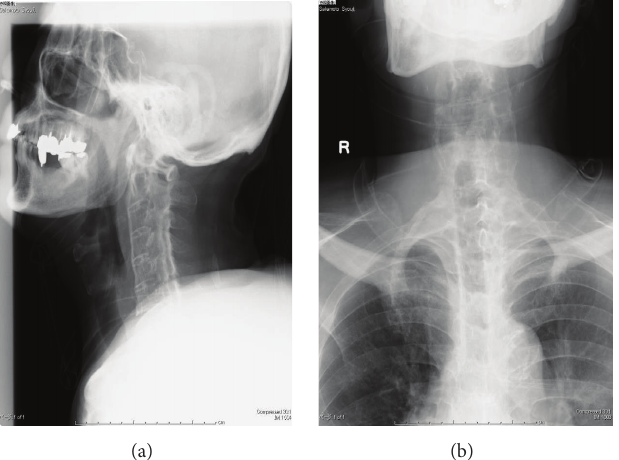
Figure 1: Plain radiographs of the cervical spine were unremarkable in detecting a cervical spine fracture in a patient with AS although the typical radiographic features of AS were apparent in entire spine ((a) AP and (b)